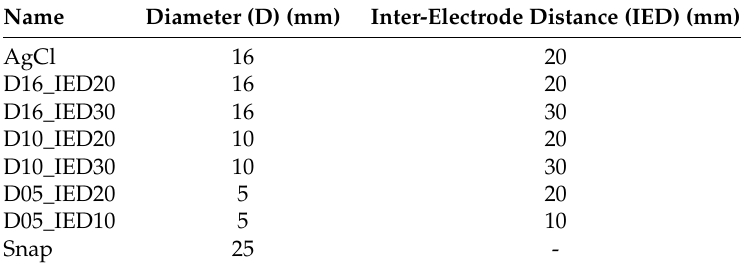
Figure 1. CAD drawing of the electrodes; grey parts are conductive, orange part are dielectric. The dimension are indicated in mm. The inter-electrode distance (IED) and the diameter (D) are variable and listed in Table 2. Table 2. Sensing structures and corresponding dimensions. The electrodes’ names of the bi-polar 3D-printed electrode represent their size, i.e., D16_IED20 has a diameter (D) of 16mm and inter-electrode distance (IED) of 20mm.